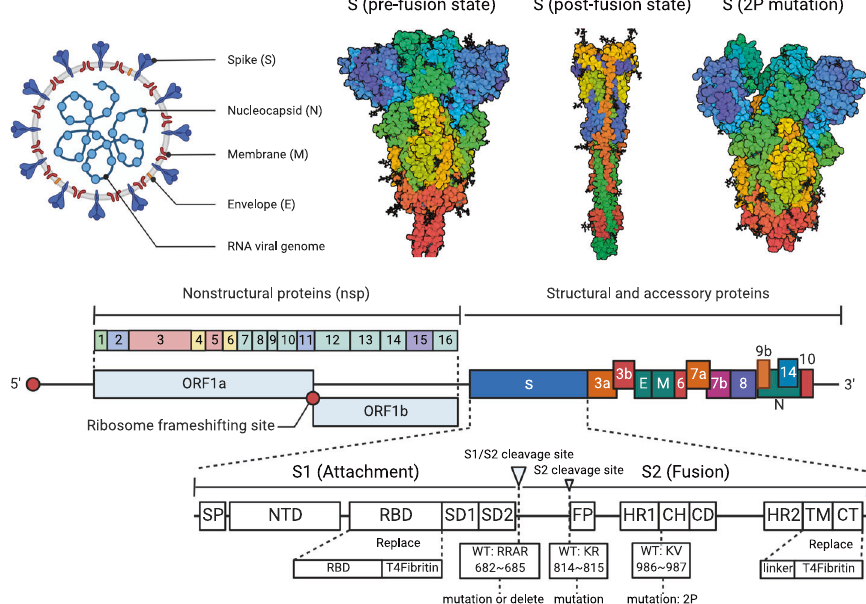
Fig. 6 Rationale underlying the design strategy of COVID-19 mRNA vaccine. Representation of the SARS-CoV-2 reference genome showing structural, nonstructural, and accessory proteins, consisting of ORF1a, ORF1b, Spike protein (S), ORF3a, ORF3b, Envelope (E), Membrane (M), ORF6, ORF7a, ORF7b, ORF8, ORF9b, ORF14, Nucleocapsid (N) and ORF10. 485 Spike and receptor-binding domain (RBD) proteins are mainly used as target antigens for the design and optimization of COVID-19 mRNA vaccines. This fi gure is created with